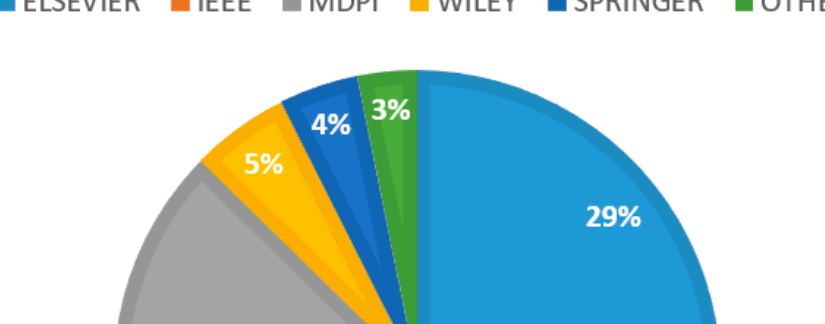
Table 2. Narrative review research directions studied.